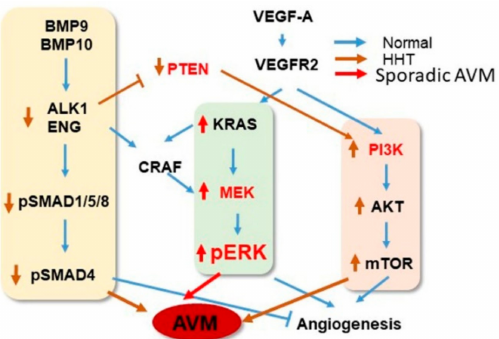
Figure 1. Signaling pathways and therapeutic targets. Normally, BMP9 / TGF β 1 regulates angiogenesis through binding to ALK1 / ENG to phosphorylate SMAD and increase PTEN activity, which in turn reduces PI3K signaling (blue lines and arrows). BMPs can also signal through MEK / ERK. In HHT (brown lines and arrows), mutation of ALK1 or ENG reduces pSMAD and PETN, resulting in increased PI3K activity or pERK level, causing AVM development. In sporadic AVM cases (red line and arrows), activating mutation in genes in the MAPK-ERK signaling pathway, such as KRAS, BRAF, and MAP2K1, increases the level of pERK, leading to AVM development or progression. The upregulation of PI3K may enhance AVM progression through exacerbation of angiogenesis in HHT. The genes in red can be tested as therapeutic